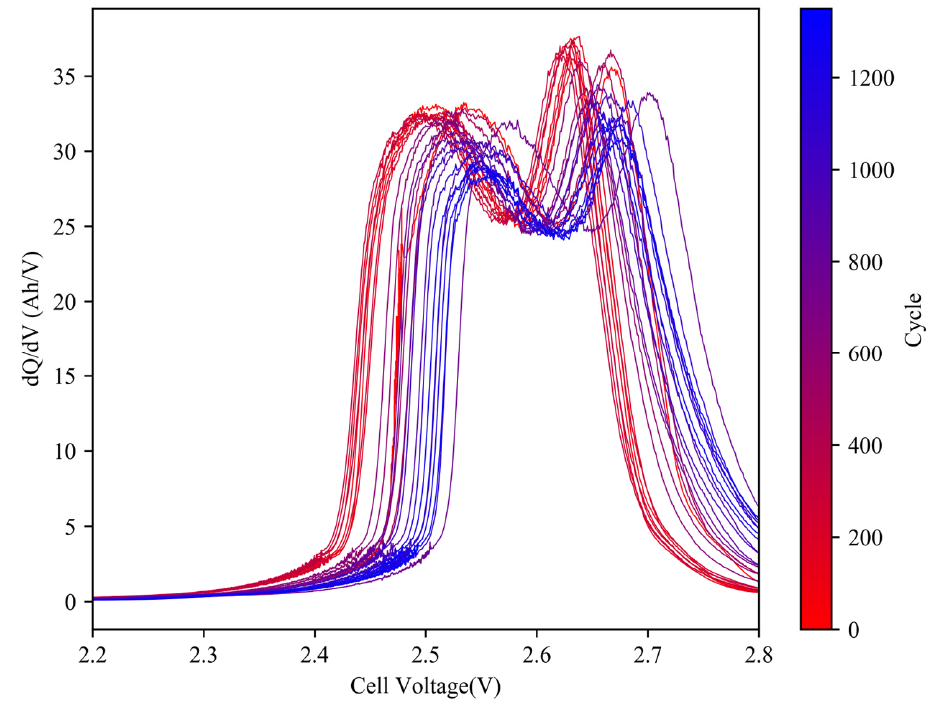
Figure 10. Evolution of IC curves (2 C) of cell #7 during aging cycles.